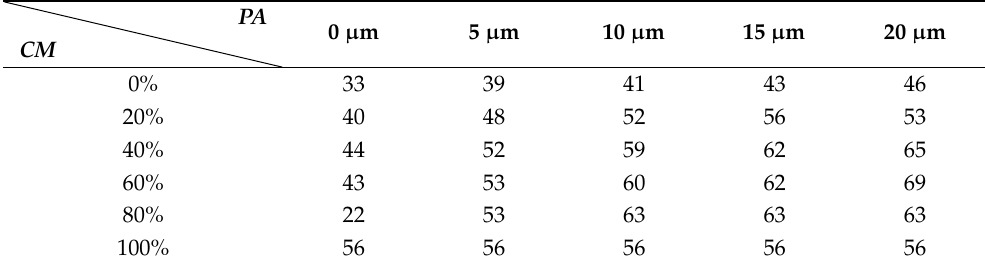
Table 10. Settling time for combinations of PA and CS .